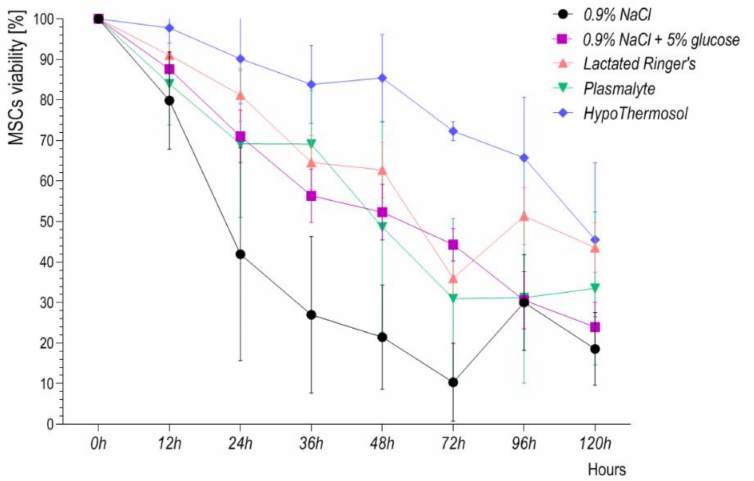
Figure 4. ADSC viability in 0.9% NaCl, 0.9% NaCl with 5% glucose, lactated Ringer’s solution, Plasmalyte, and HypoThermosol FRS monitored over 120